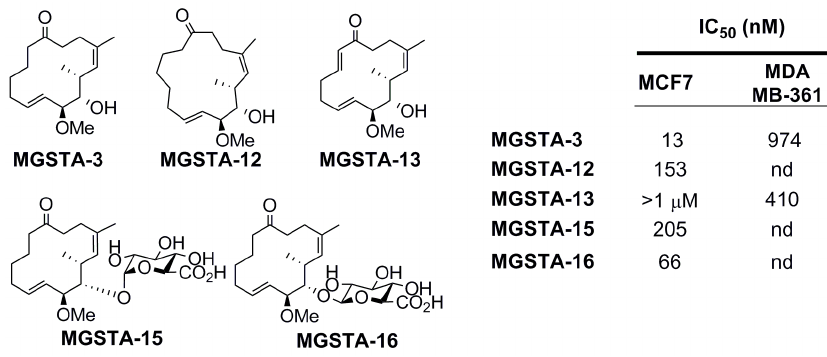
Figure 9. Structures of selected migrastatin analogs and effect on human breast cancer cell lines MCF7 and MDA MB-361 assessed with Boyden chamber